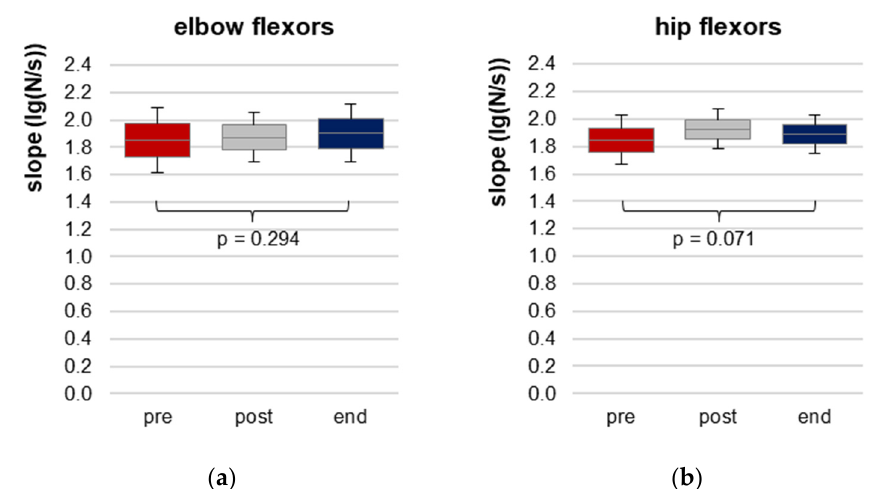
Figure 3. Slope of force increase during the AF assessment. Displayed are arithmetic means, standard deviations (error bars) and 95% CIs of the logarithmic slope (lg(N/s)) of force increase during manual muscle tests for elbow ( a ) and hip flexors ( b ) at each time point pre (red), post (grey) and end (blue). RM ANOVA was non-significant, p -values of RM ANOVA are given.